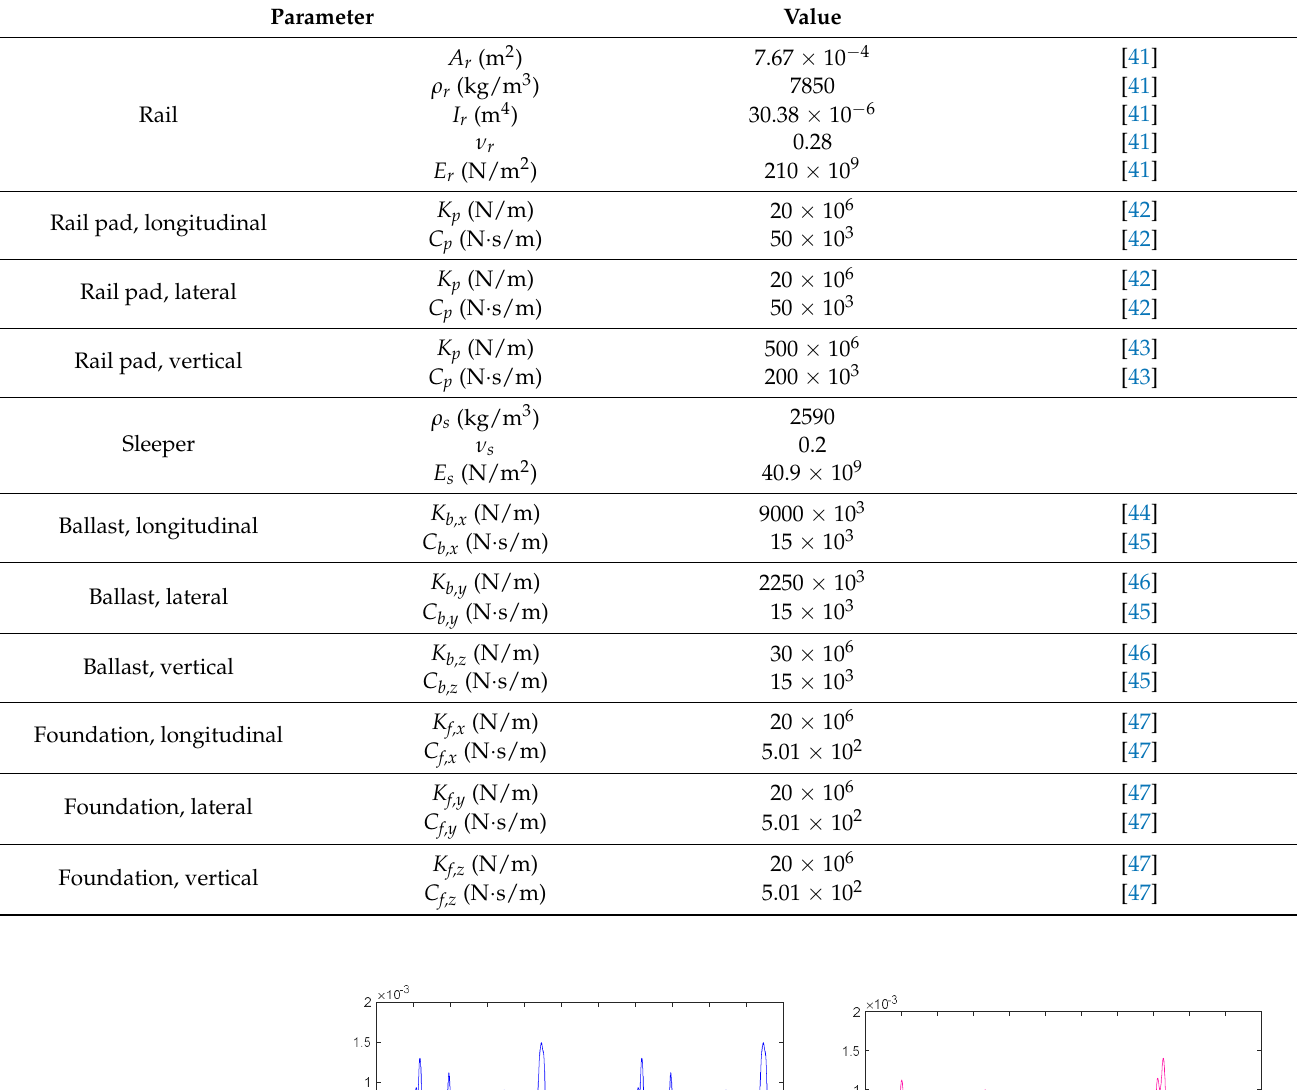
Table 3. Mechanical properties of the track.